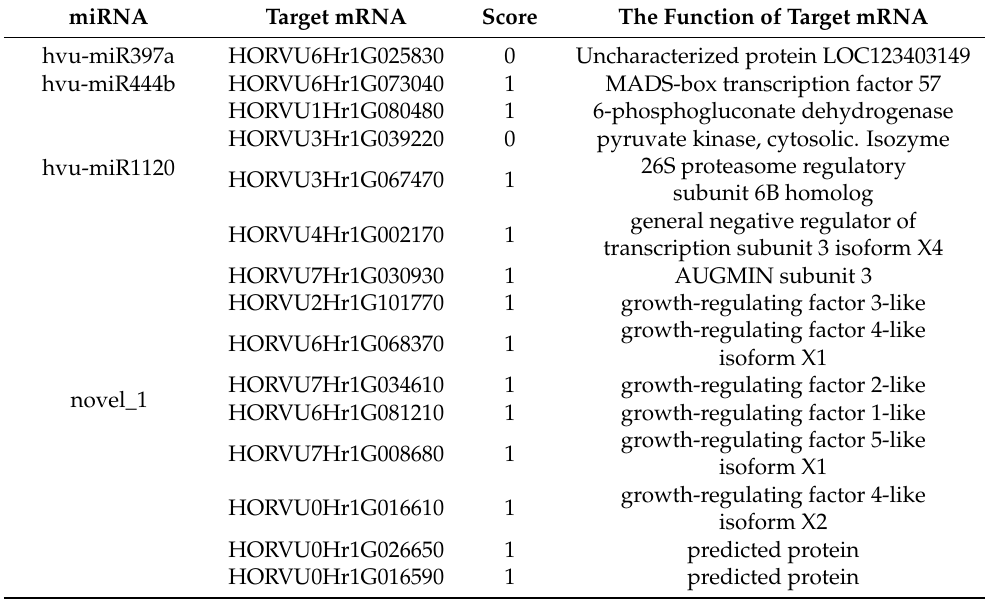
Table 4. Functions of target mRNA corresponding to upregulated miRNA in 3 dai vs. mock. miRNA Target mRNA